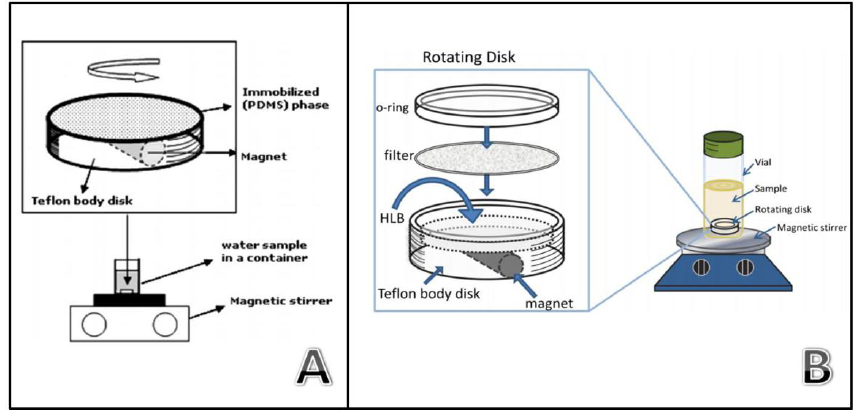
Figure 10. Device for rotating disk sorptive extraction using thin films (Reproduced with permission from [56], copyright Elsevier, 2009) ( A ) and sorbent particles (Reproduced with permission from [63], copyright Springer, 2014) ( B ).